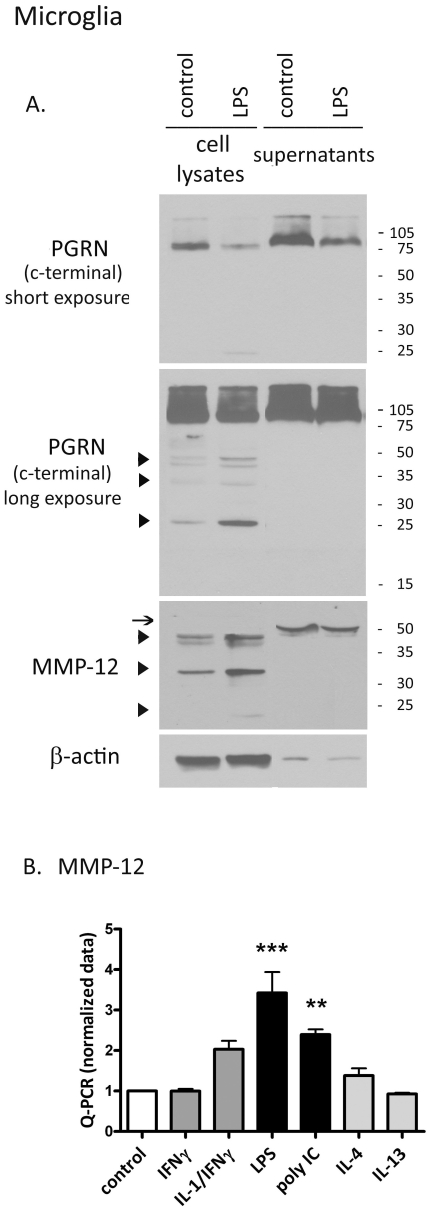
PGRN is cleaved by macrophage elastase MMP-12 in human microglia.(A) Microglia were incubated with medium alone (control) or LPS for 24 h. Culture supernatants were concentrated ∼25 fold using a 3 kDa cutoff filter. Equal amounts (30 µg) of protein from cell lysates and culture supernatants were loaded in each lane. Blots were probed for PGRN using a C-terminal specific antibody, and for MMP-12 and β-actin. Data are representative of three independent experiments with similar results. (B) Microglia cultures were examined for MMP-12 mRNA expression by Q-PCR (6 h stimulation). Pooled normalized data from 3 different cases are shown. ** p<0.01, ***p<0.001.